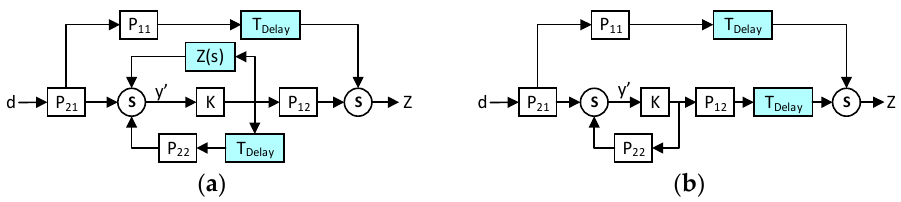
Figure 9. Block diagram of the load sharing control method presented in [99]: ( a ) with light-blue blocks to obtain a uniform delay time; ( b ) with a uniform delay time.